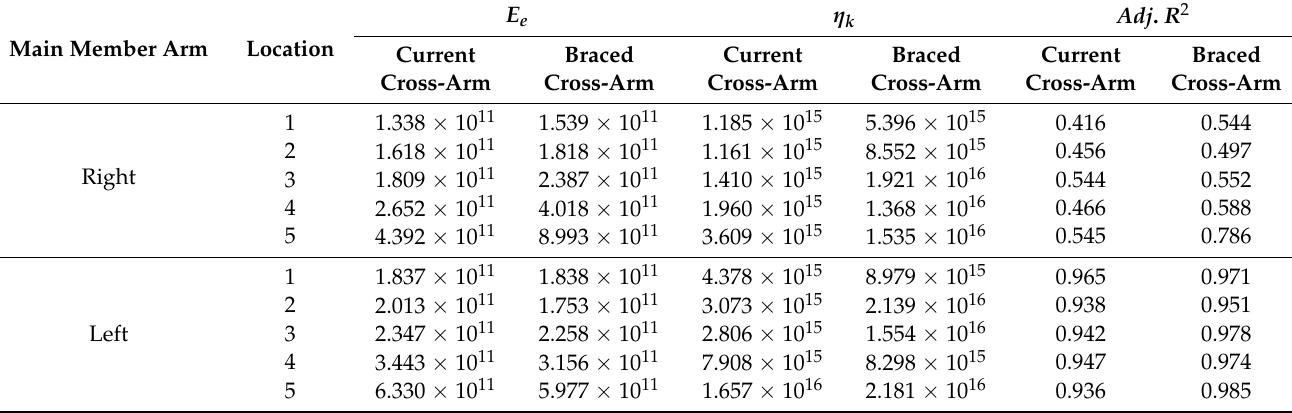
Table 3. Elastic and viscoelastic parameters from Burger model for current and braced PGFRPC cross-arms.